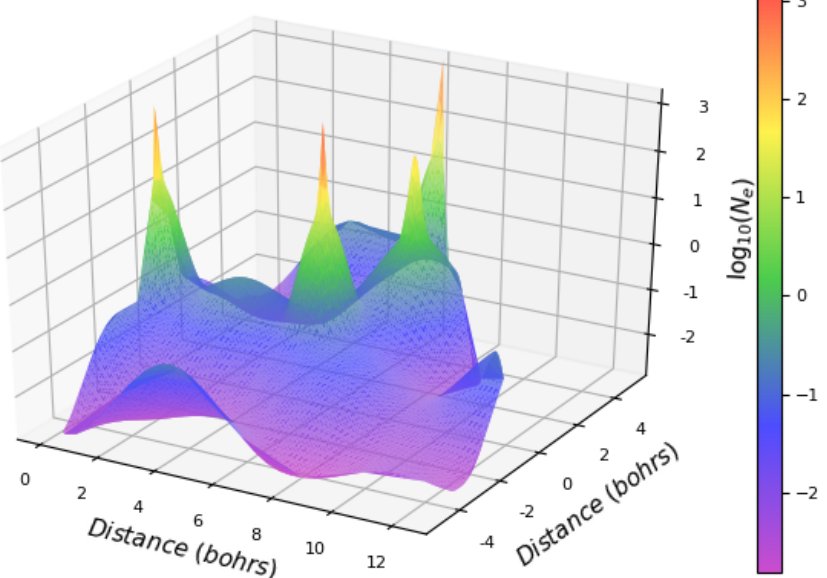
Figure 1. Electron density inside a quartz ( SiO 2 ) cell obtained with DFT calculations using Quantum Espresso code [18]. Shown is the electron density (in atomic units) in a plane through the cell that cuts very close to three silicon nuclei (higher peaks), and two oxygen